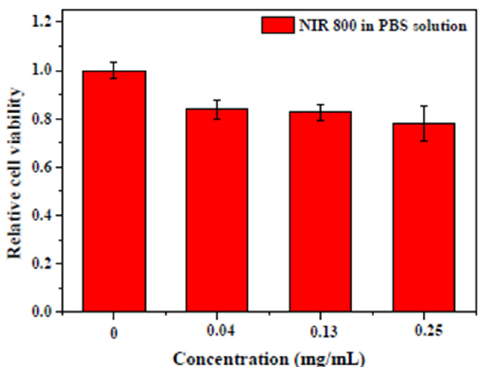
Figure 8. Relative cell viability of human umbilical vein endothelial incubated with a series of concentration in PBS solution of NIR 800 measured by the MTT cell viability assay.